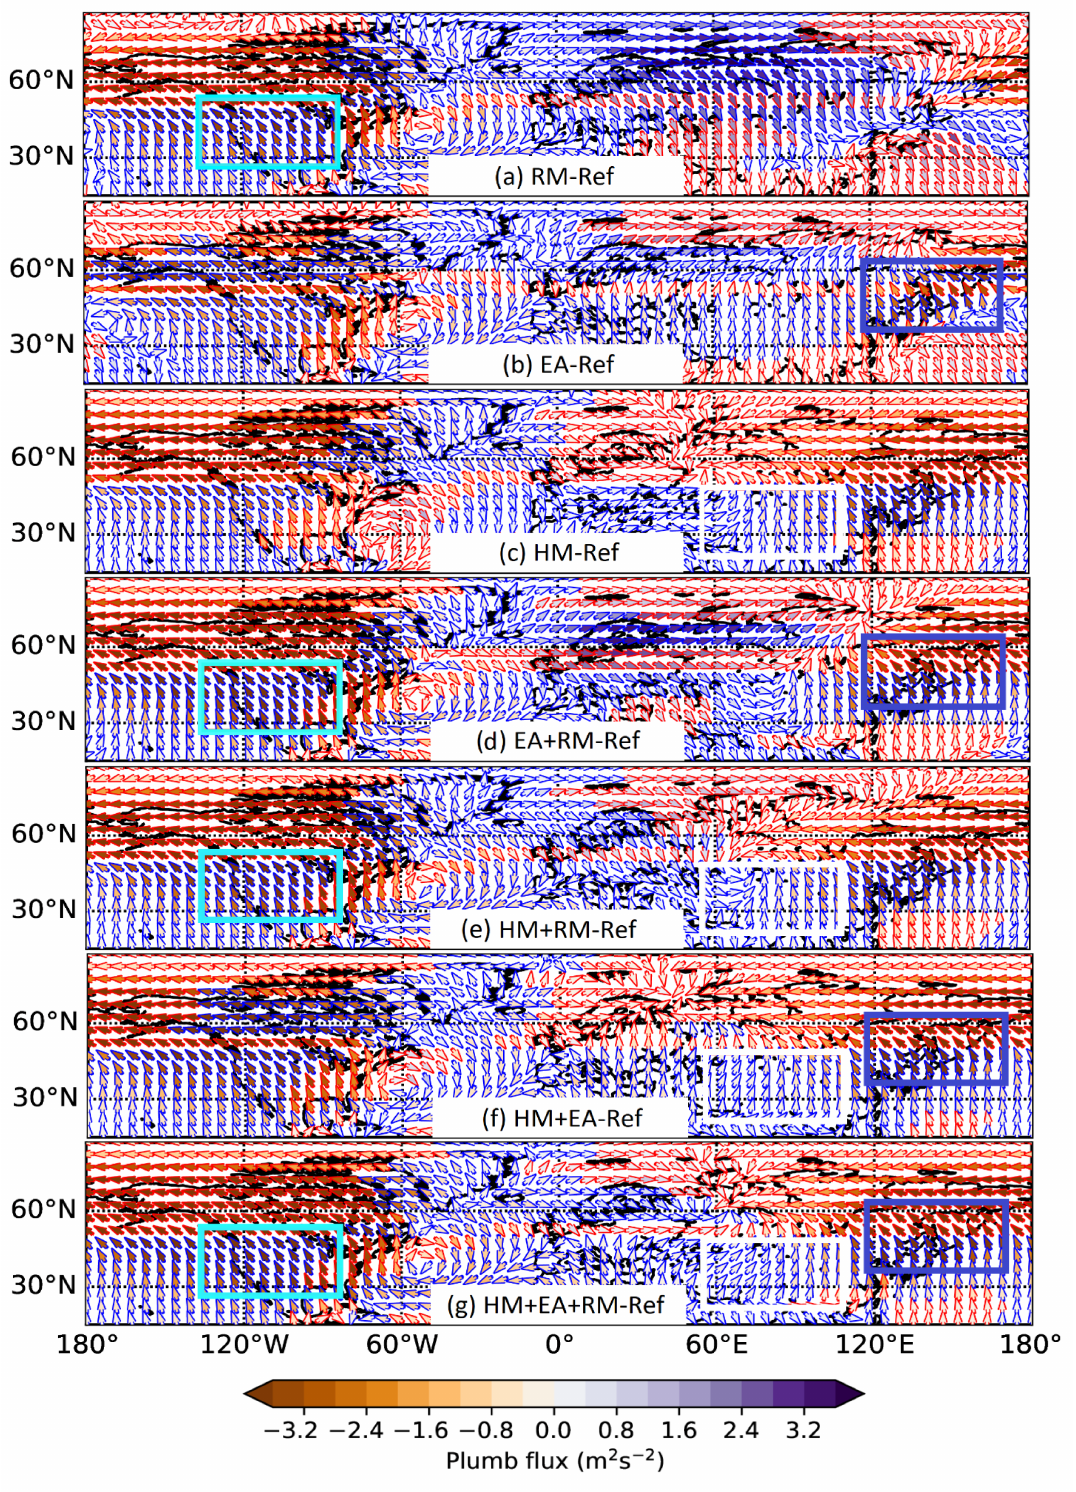
Figure 7. Three-dimensional Plumb flux differences between each simulation and the Ref simulation at 38km altitude. The difference in the horizontal flux is illustrated by the colored arrows indicating direction and strength. The difference in the vertical component is illustrated by the edge color of the arrows. The position of the GW hotspots is illustrated by the boxes. RM − Ref ( a ), EA − Ref ( b ), HI − Ref ( c ), RM + EA − Ref ( d ), RM + HI − Ref ( e ), HI + EA − Ref ( f ), RM + HI + EA − Ref ( g